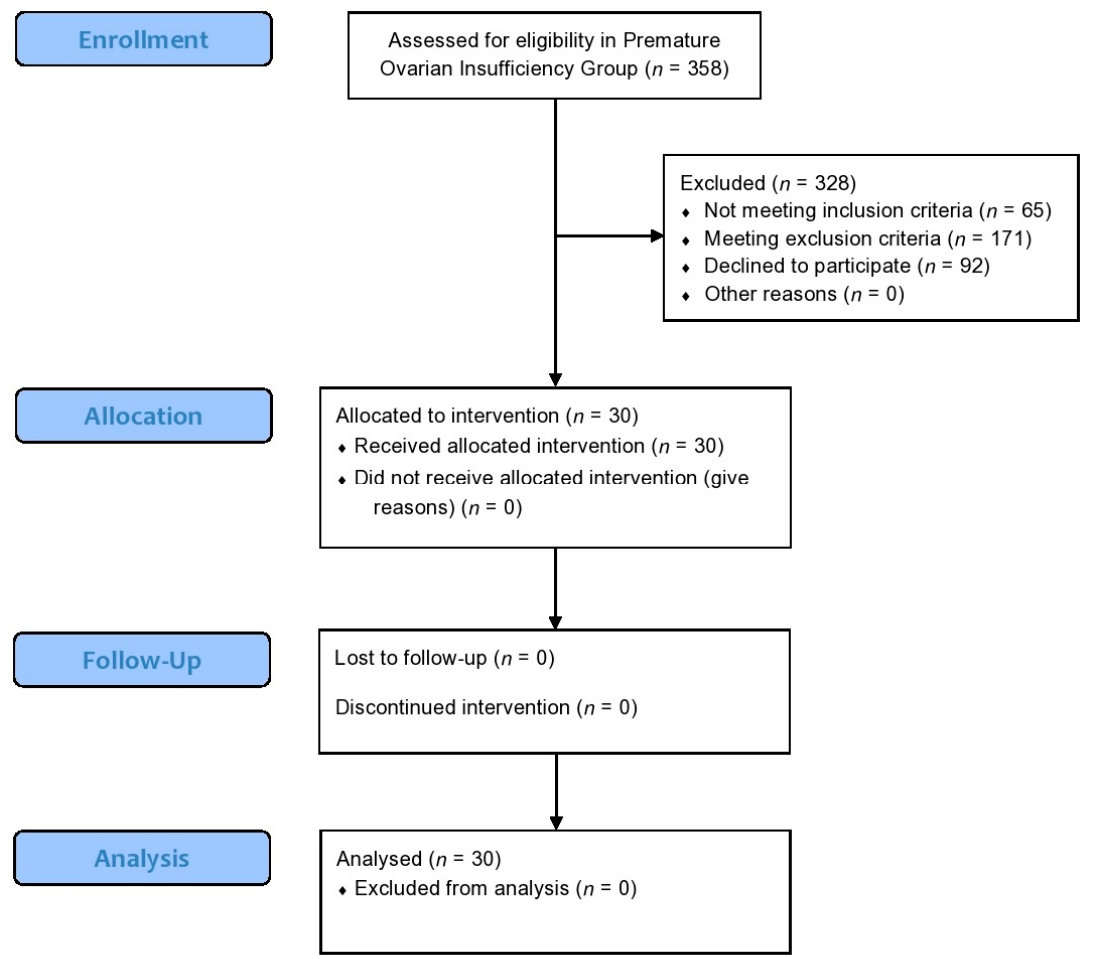
Figure 3. A modified version of CONSORT flow-chart presenting enrollment, allocation, follow-up and analysis of participants regarding the Premature Ovarian Insufficiency pilot study.